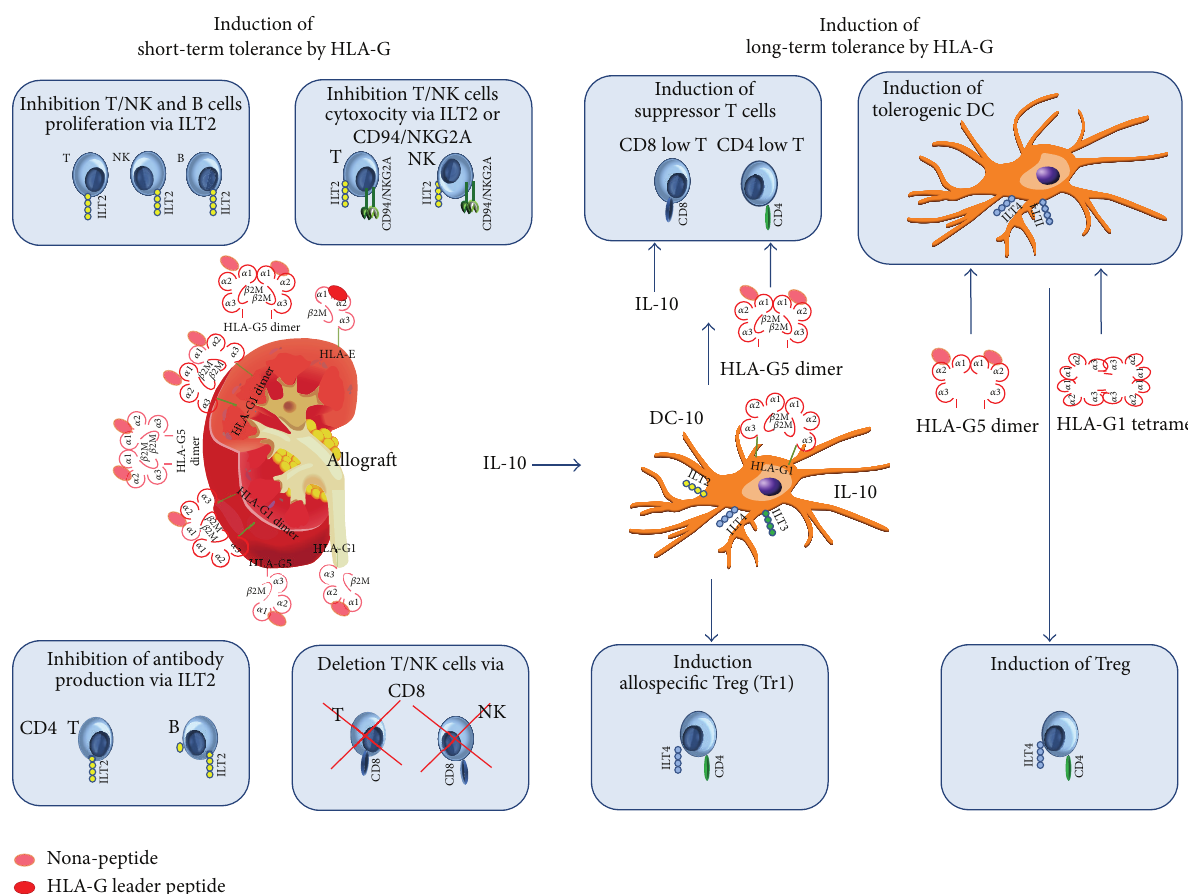
Figure 1: Induction of short- and long-term tolerance by HLA-G. Short-term tolerance will be achieved by HLA-G via interaction of allograft derived monomeric or dimeric 𝛽 2-associated HLA-G1 and HLA-G5 molecules with the ILT2 receptor on T, NK, and B cells resulting in the inhibitionofcytotoxicity,proliferation,orantibodyproduction.Short-termtolerancecanbeindirectlyinducedbyHLA-Gviathepresentation of HLA-G specific leader peptide through HLA-E and its interaction with the cognate inhibitory receptor heterodimer CD94 and NKG2A on T and NK cells subsets. The interaction of HLA-G5 with CD8 coreceptor on certain T and NK cell population leads to the deletion of these cells. Long-term tolerance will be achieved by the induction of different types of regulatory T (Treg) cells. Allospecific Treg (Tr1) will be generated by so-called DC-10 cells expressing ILT2, 3, 4 receptors together with 𝛽 2-free or -associated HLA-G1 via a ILT4/HLA-G pathway. Suppressor T cells expressing low CD4 or CD8 coreceptors are induced in the presence of HLA-G5 molecules together with IL-10 or HLA-G positive antigen presenting cells. The interaction of non- 𝛽 2-associated HLA-G5 dimers or HLA-G1 tetramers with ILT4 antigen presenting cells results in the induction of tolerogenic DC, which favours the induction of